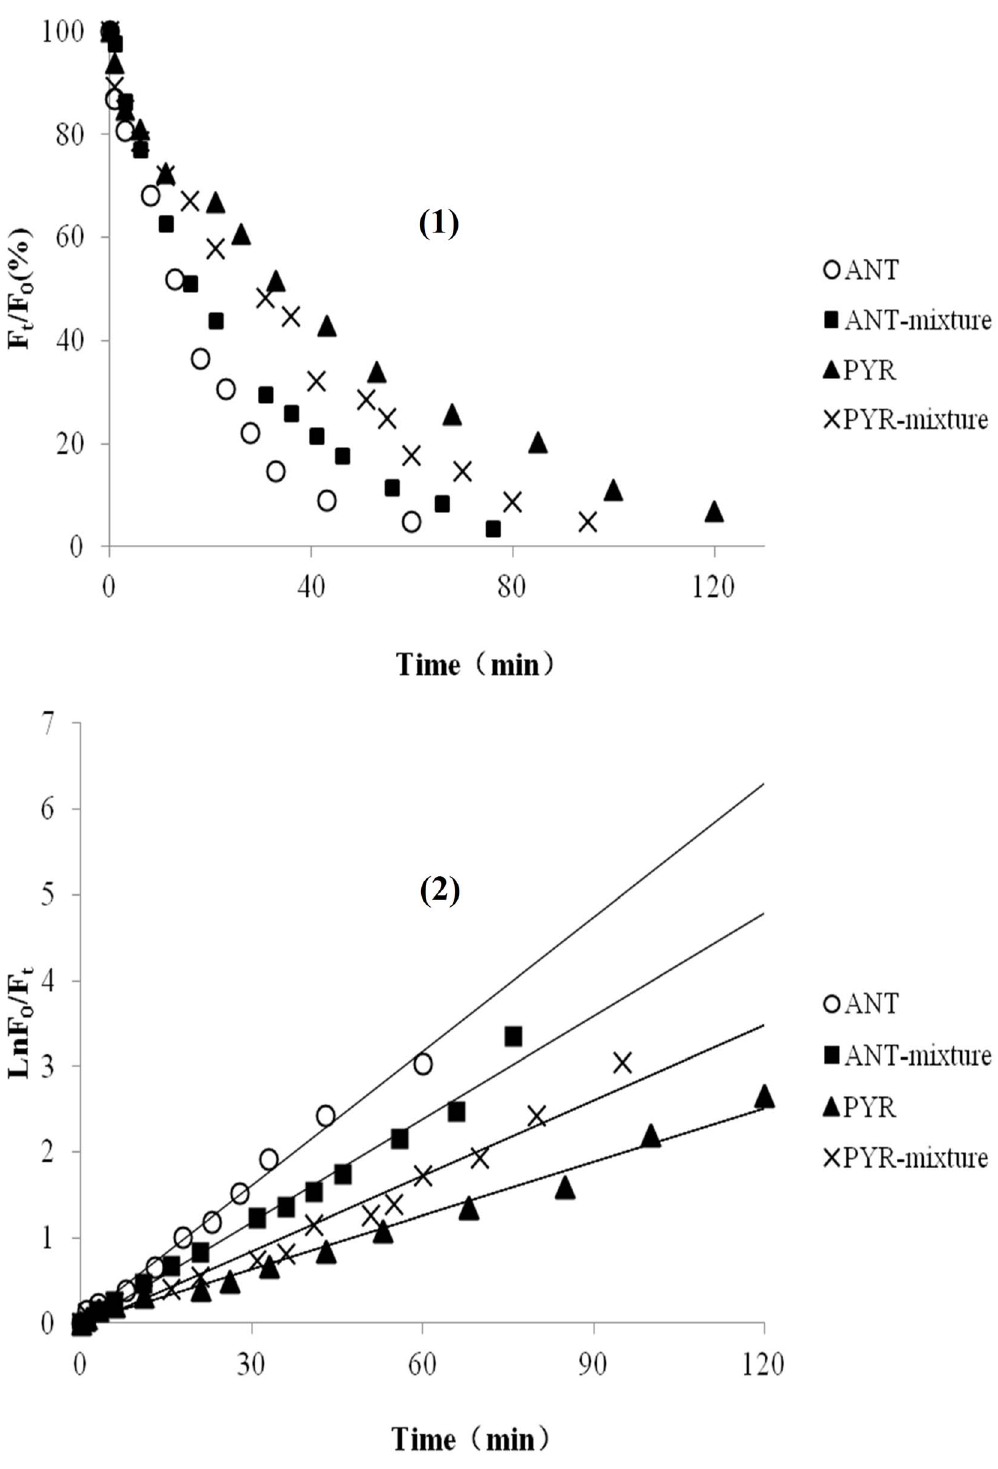
Figure 5. Photodegradations of ANT (0.25 nmol) and PYR (0.25 nmol) in water as single component and in multicomponent mixtures. (1): Change in F t /F 0 over time during the photodegradation of the two PAHs adsorbed onto the leaves of the two mangrove species. (2): First-order kinetic plots of the photodegradation of the two PAHs adsorbed onto the leaves of the two mangrove species. doi:10.1371/journal.pone.0104903.g005 mixtures followed first-order reaction kinetics (Figure 5). The component and in multicomponent mixtures [33,39]. Experimen- tal results showed that the photodegradation of PYR and ANT photodegradation rate of each PAH in water as single component dissolved in water as single component and multicomponent and in multicomponent mixtures was faster compared with the